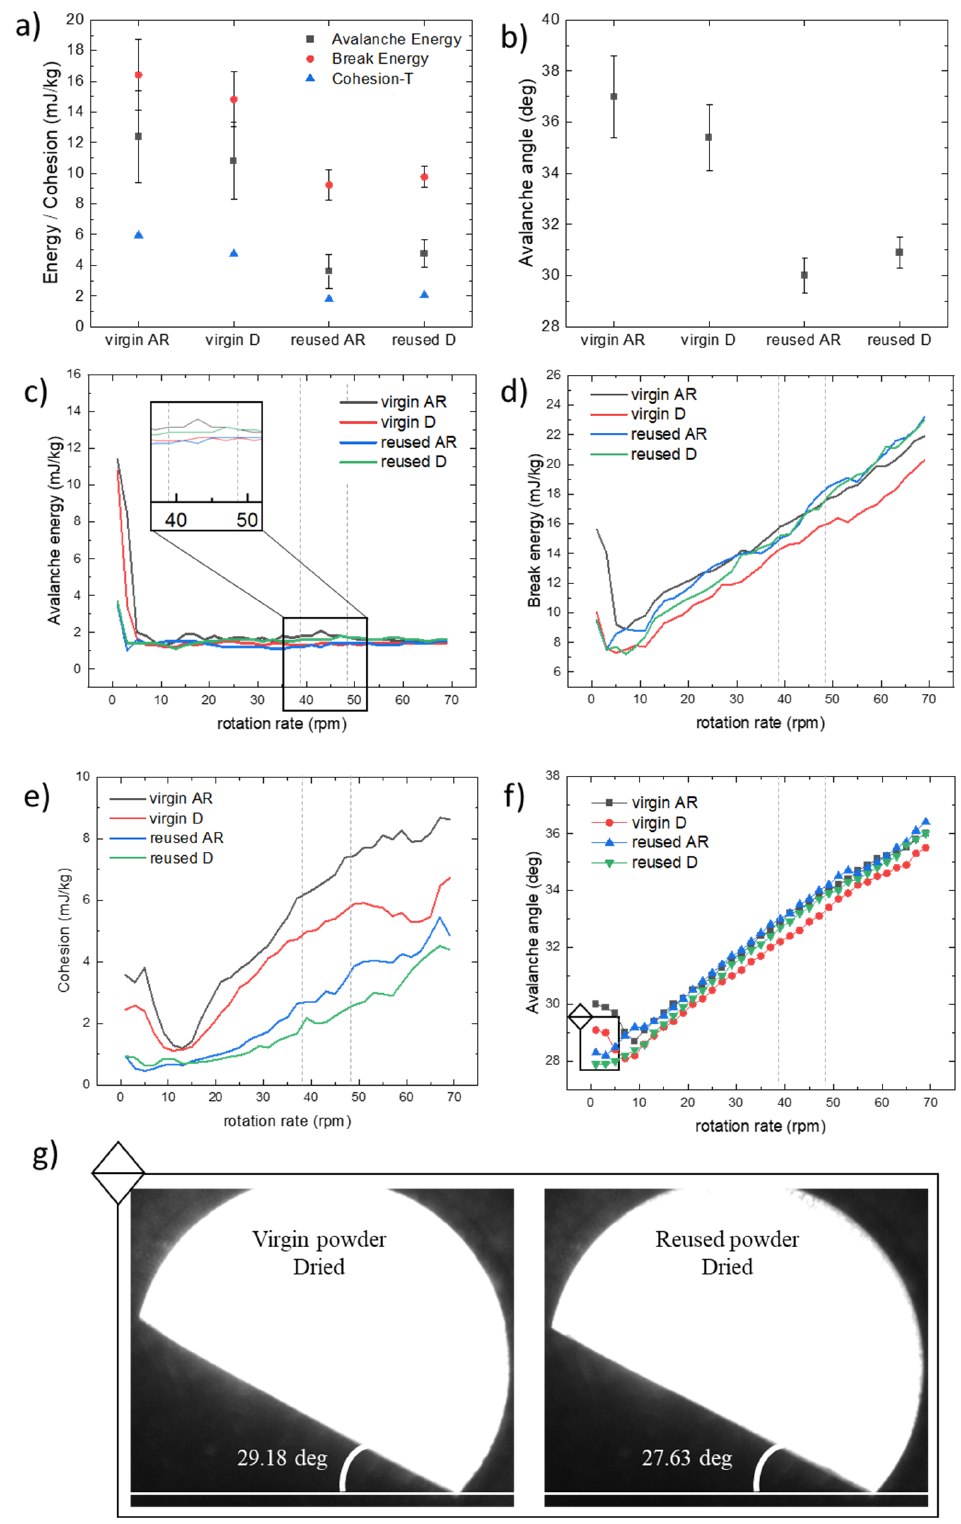
Figure 7. ( a ) Flowability metrics (avalanche energy, break energy and cohesion) and ( b ) avalanche angle using a constant speed of 0.6 RPM. Multi-flow test metrics ( c ) avalanche energy, ( d ) break energy, ( e ) cohesion and ( f ) avalanche angle. ( g ) Avalanche morphology at 1 RPM. All measurements show the behavior of virgin and reused powder in as-received (AR) and dried (D) condition.